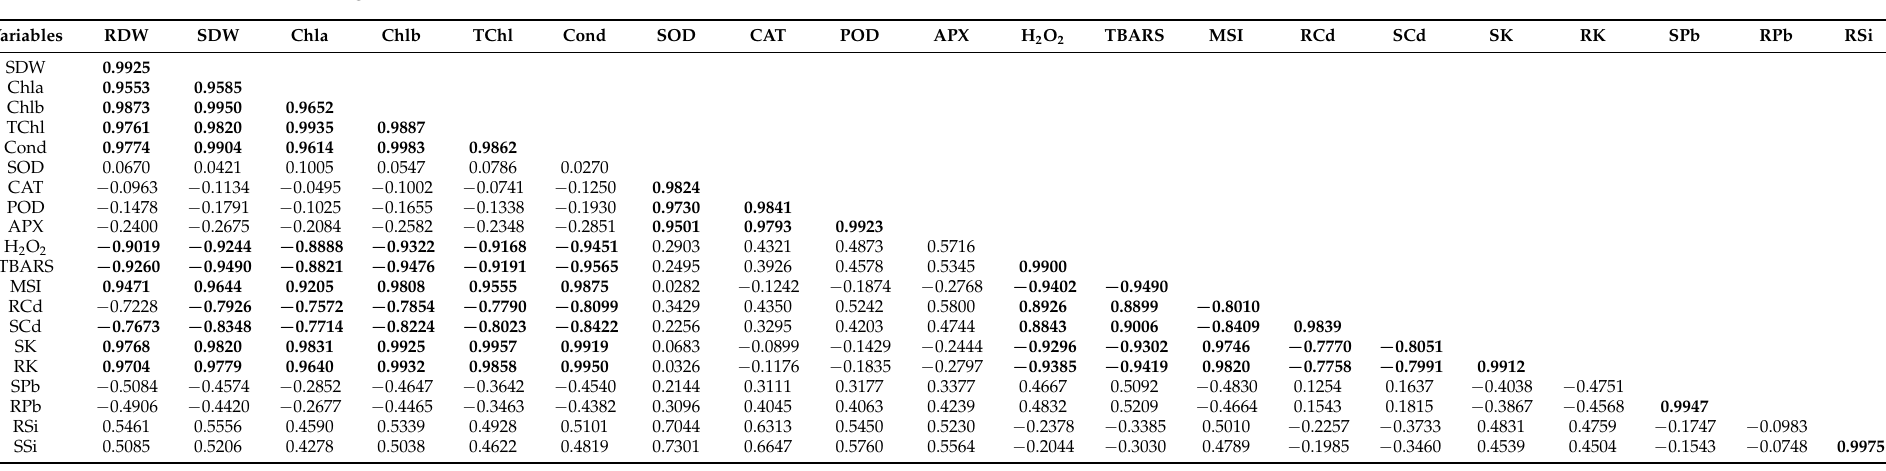
Table 4. Pearson correlation matrix of different attributes of quinoa under Cd and Pb in the presence of Si and K. Values in bold indicate a significant relationship among different